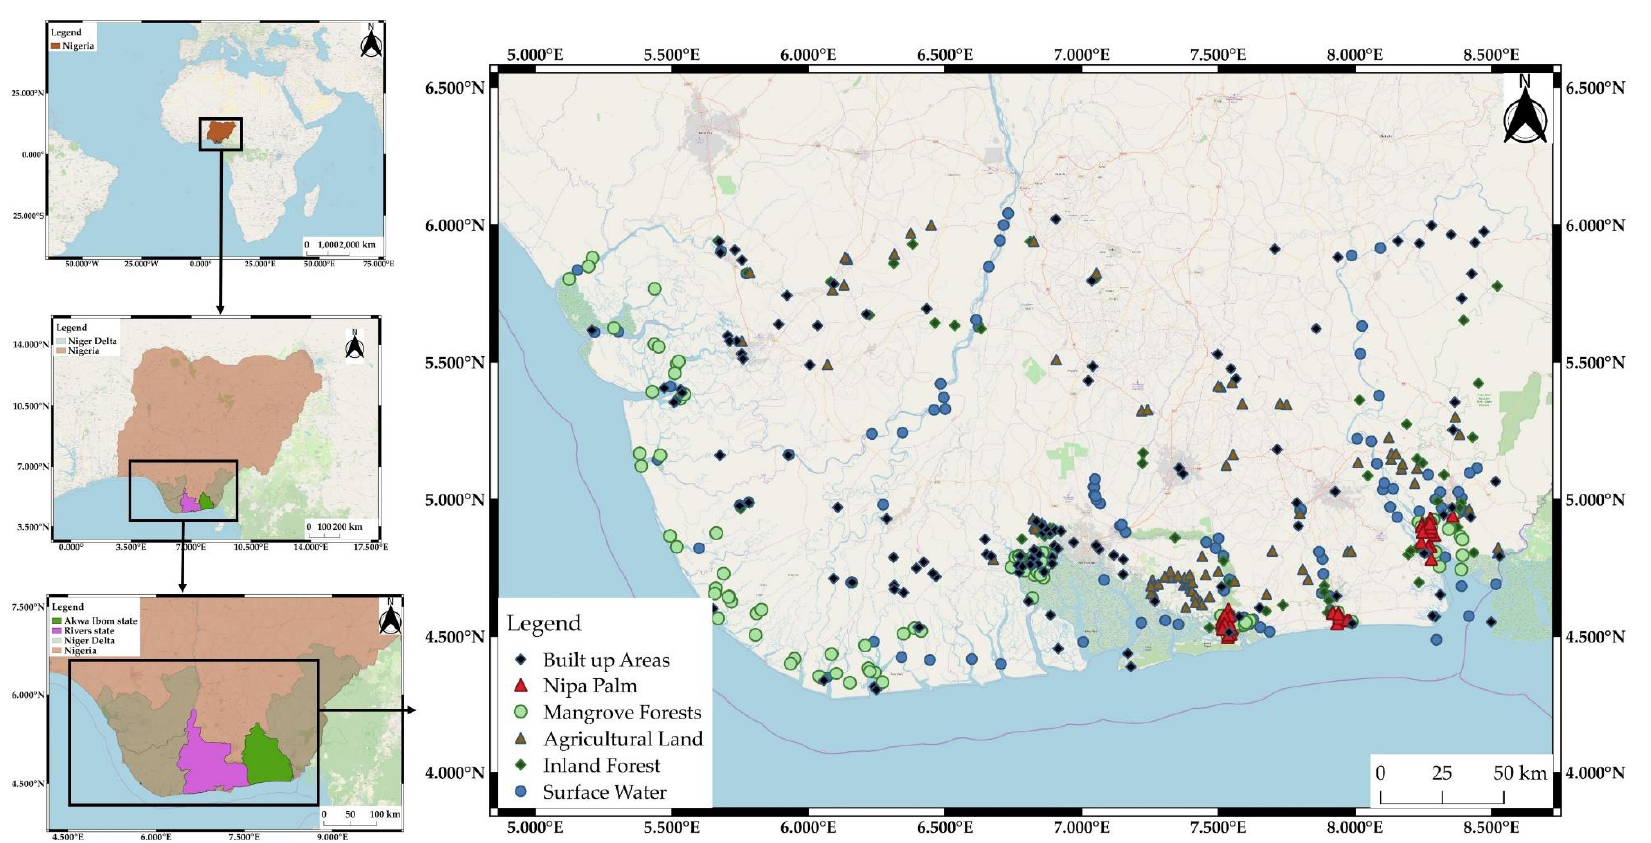
Figure 1. Location of Nigeria in West Africa, the Niger Delta in Southern Nigeria, study area, and ground control points (GCPs) established during the field survey.